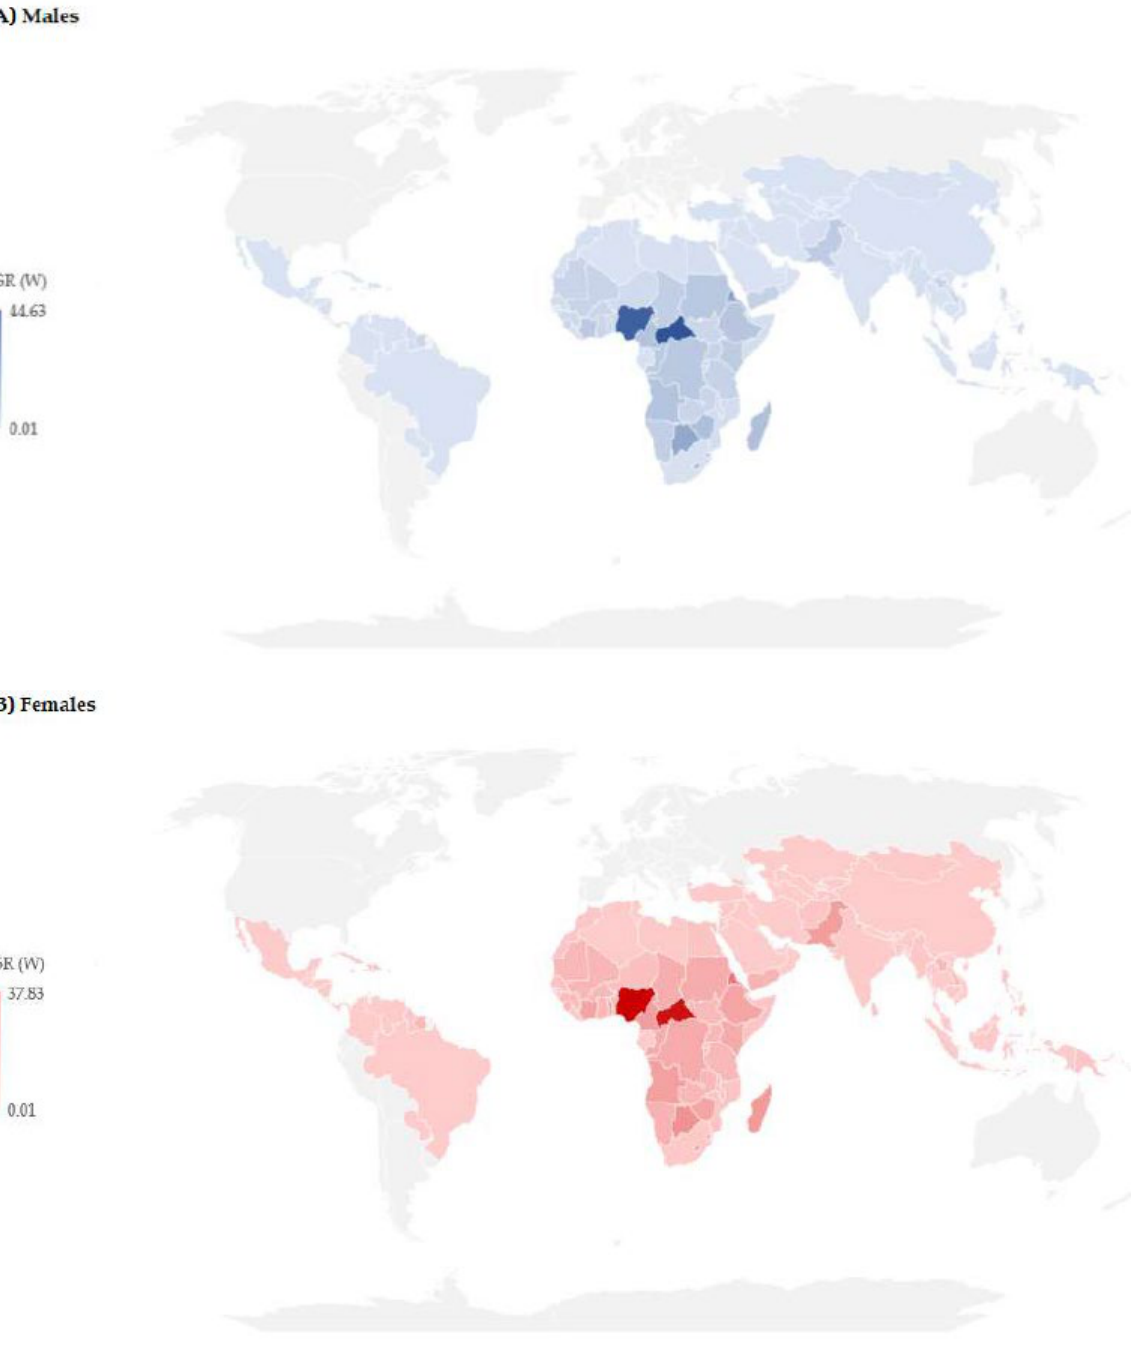
Figure 4. Estimated age-standardized rates (ASRs, per 100,000 population) of cholera mortality by countries and by sex (( A ) Males; ( B ) Females), 2019 (Source of data Ref. [10]). Globally, the trend for cholera-related mortality rates in both sexes together from 1990 to 2019 was stable (by − 0.2% per year, 95% CI = − 0.5 to 0.1) (Figure 5). When the cholera mortality trend was analyzed by six WHO regions, significantly decreasing trends were observed in three regions, the European Region (by − 10.7% per year, 95% CI = − 11.6 to − 9.8), the Western Pacific Region (by − 8.2% per year, 95% CI = − 8.5 to − 8.0), and the South-East Asia Region (by − 7.4% per year, 95% CI = − 7.8 to − 6.9). In the African Region, a significantly increasing cholera-related mortality trend was observed (by 1.2% per year, 95% CI = 0.8 to 1.6); mortality rates increased from 8.7/100,000 in 1990 to